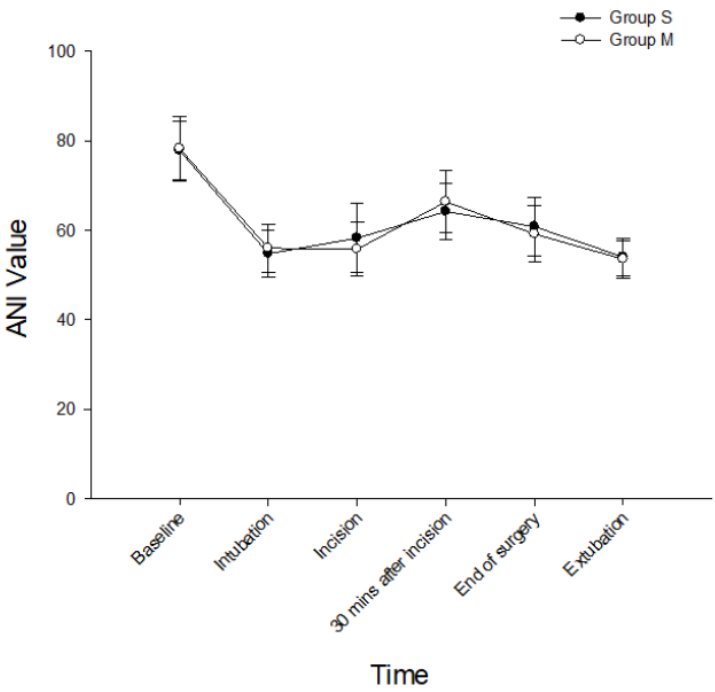
Figure 3. The ANI value for both groups at baseline and during anesthetic course. S group: propofol and remifentanil delivered by separate TCI pumps; M group: mixed propofol/remifentanil delivered by a single TCI pump; ANI: analgesia nociception index.